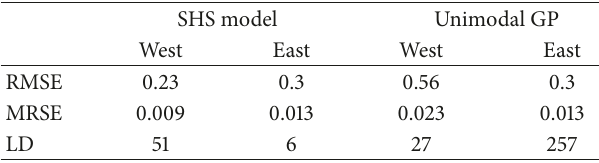
Table 3: Performance metrics for multistep prediction of both SHS model and unimodal GP